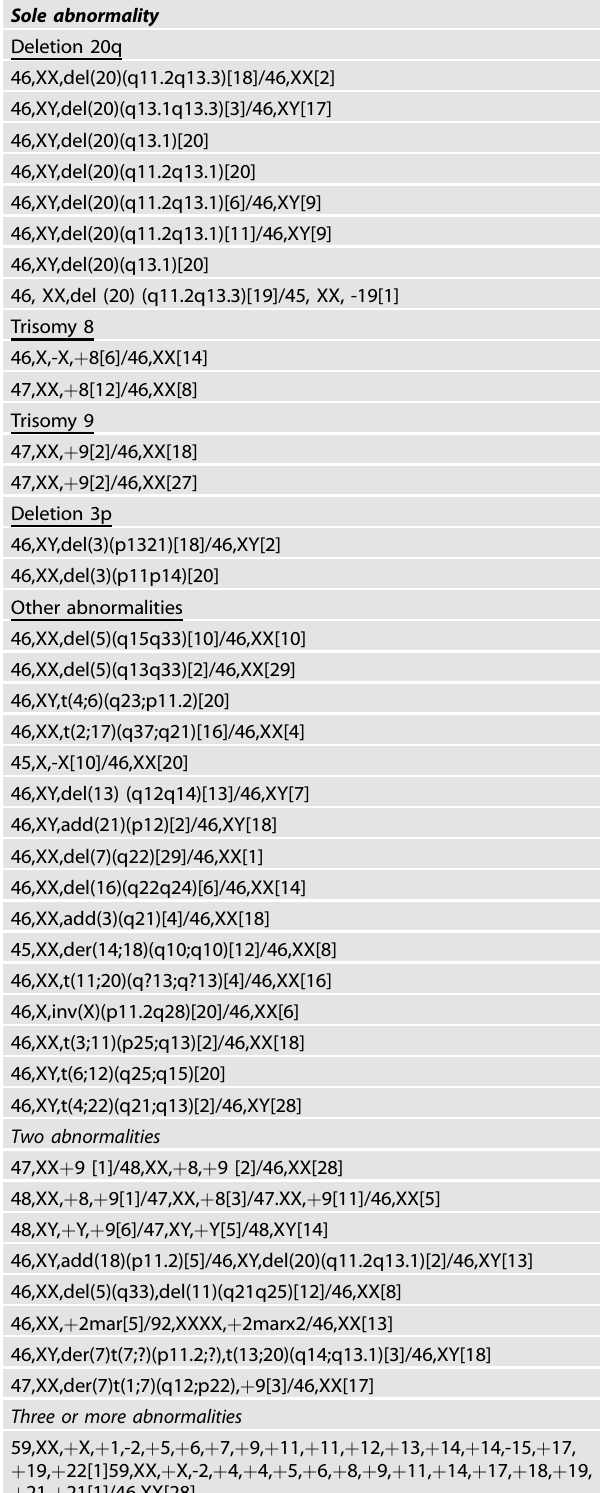
Table 1. Description of 39 cytogenetic abnormalities among 809 patients with Essential thrombocythemia